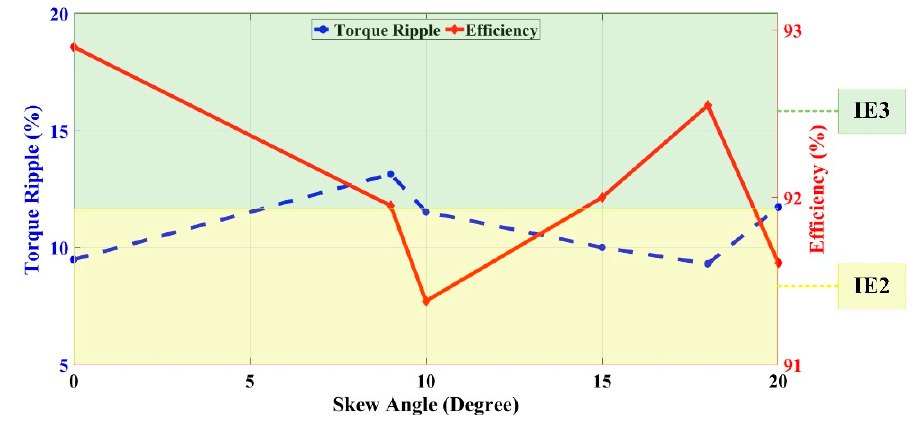
Figure 11. Efficiency and torque results of AFIM with 40 slots.